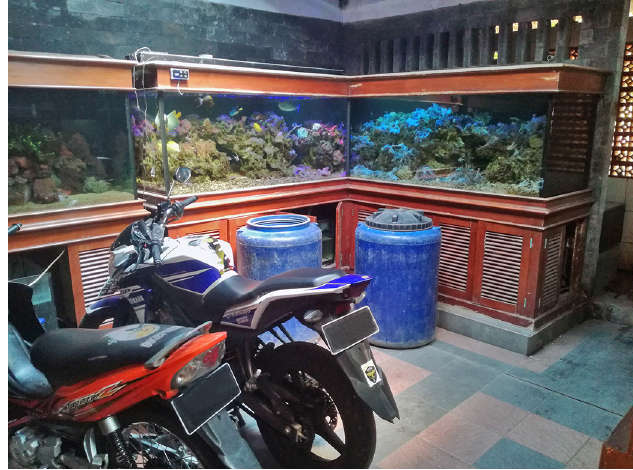
Fig. 1. Marine aquaria with animals offered for sale on the street in Jakarta, Indonesia.